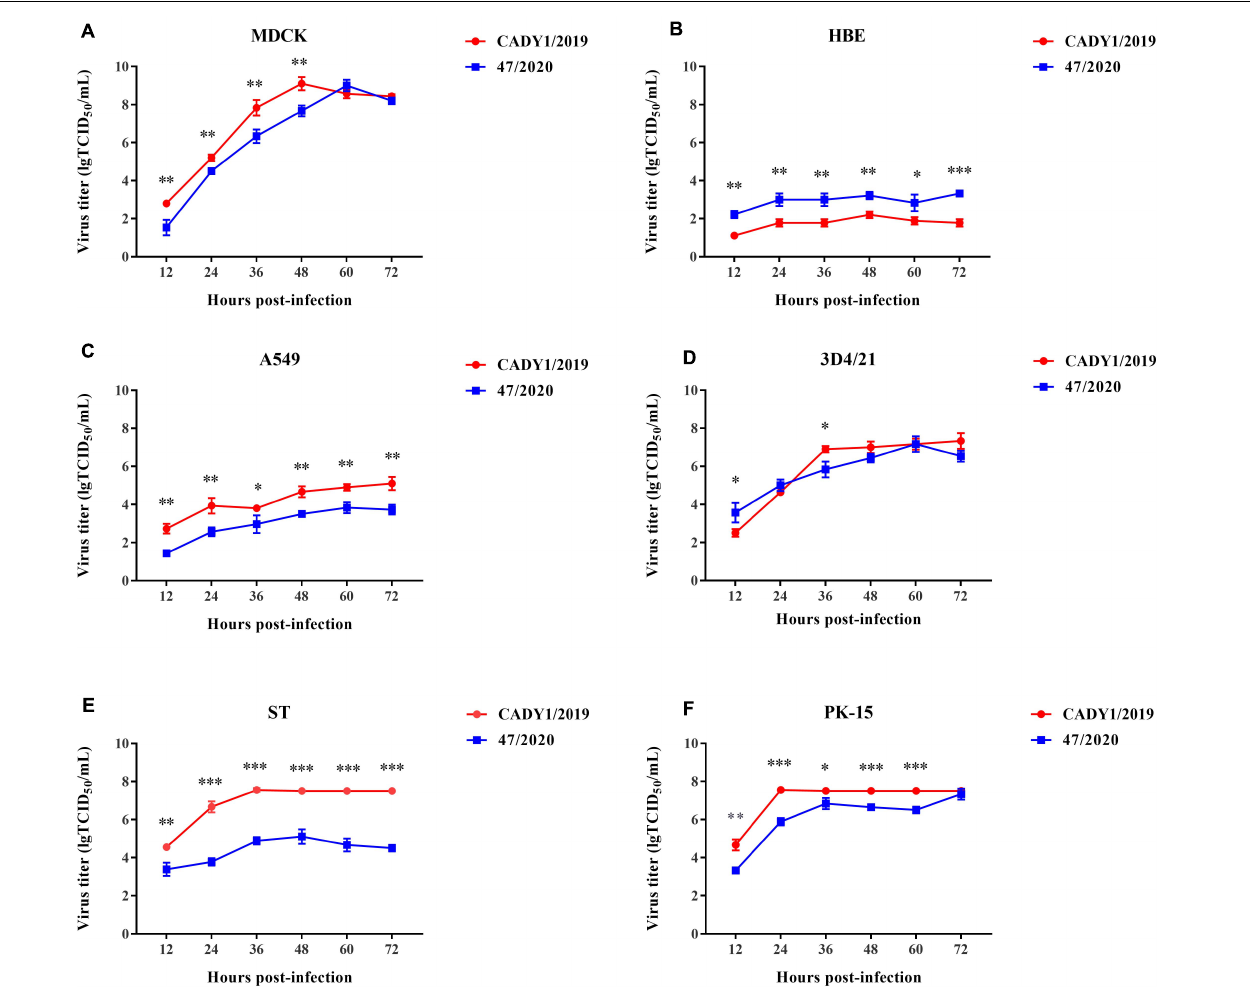
FIGURE 4 | Growth kinetics of viruses in mammalian cells. Excepting MDCK cells (A) were infected with viruses at a MOI of 0.001, HBE (B) , A549 (C) , 3D4/21 (D) , ST (E) , and PK-15 cells (F) were inoculated with viruses at a MOI of 0.01. The supernatants of cells were collected at 12, 24, 36, 48, 60, and 72 hpi and titrated in MDCK cells. The experiments were repeated for three times and the viral titer at each time point was expressed as mean ± standard deviation. Statistical analysis was performed using Prism 7.0 software (GraphPad, La Jolla, CA). ∗ indicates P < 0.05, ∗∗ indicates P < 0.01, ∗∗∗ indicates P <